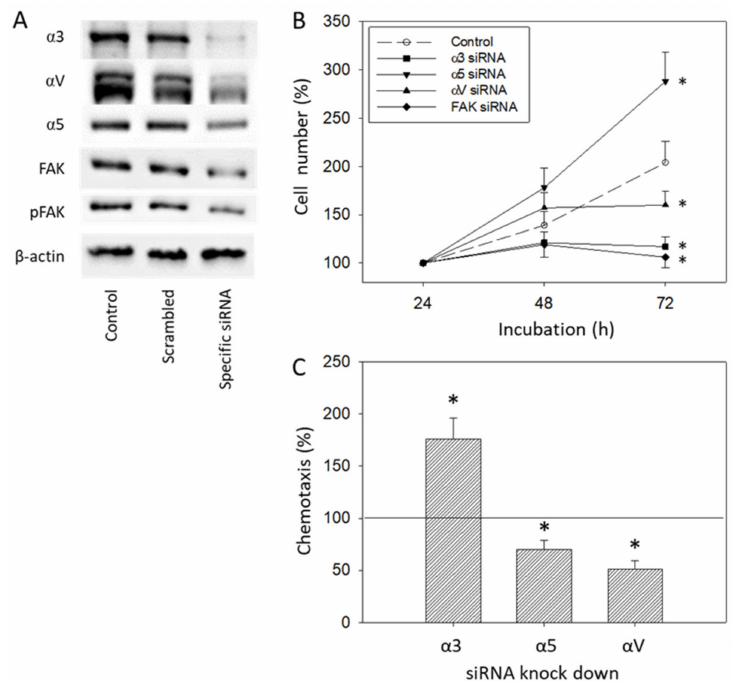
Figure 13. ( A ) Protein expression level following siRNA transfection (untreated control versus scrambled siRNA versus specific siRNA). Each protein analysis was accompanied by a β -actin loading control. One representative internal control is shown. ( B ) Cell growth of DU145 treated with an integrin α 3, α 5, α V, or FAK specific siRNA, evaluated by the MTT-assay. One representative of three separate experiments is shown. ( C ) Chemotactic movement of DU145 cells after knocking down integrin α 3, α 5, or α V. All values are related to the scrambled controls set to 100%. * indicates significant difference to controls ( n =